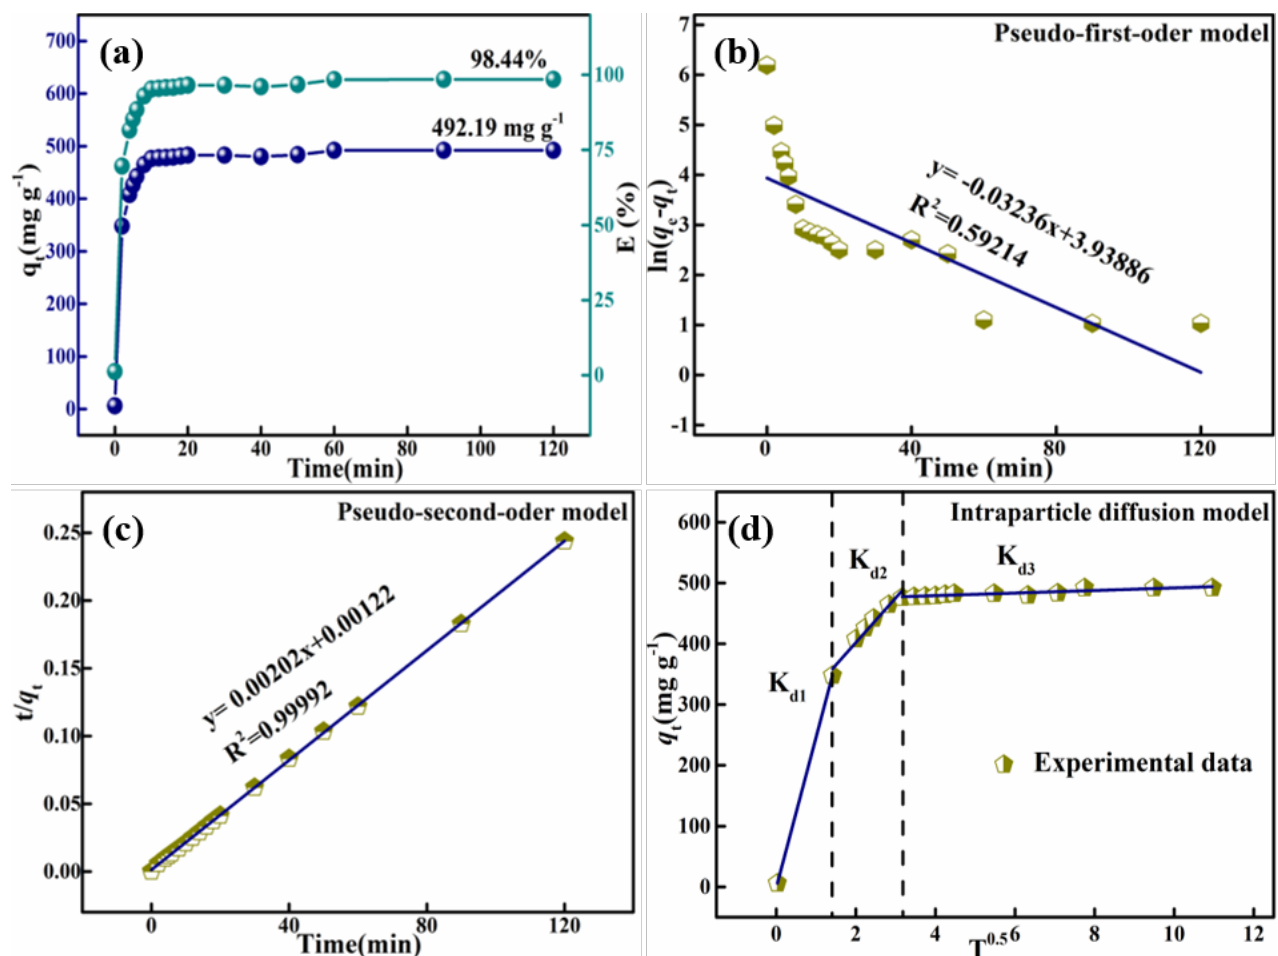
Figure 9. Variation in adsorption capacity with adsorption time for CR ( a ); pseudo-first order kinet- ics ( b ); pseudo-second order kinetics ( c ); intra-particle diffusion kinetics ( d ) for adsorption of CR on samples HPMA (T = 25 °C, adsorbent mass = 100 mg, CR concentration = 250 mg L −1 , and pH = 4).